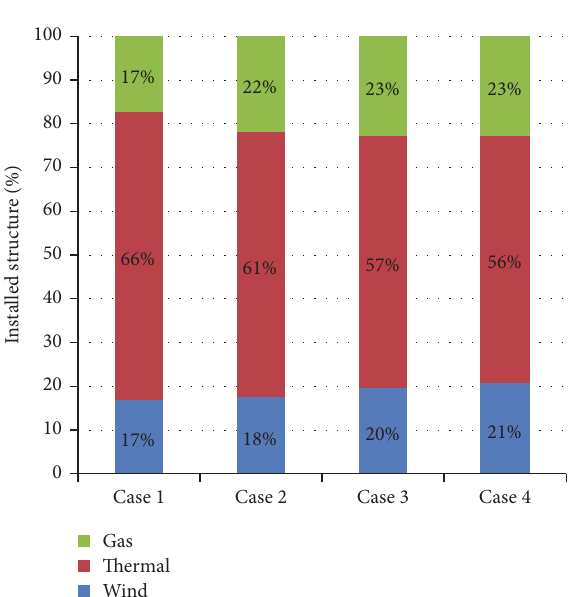
Figure 7: System installed structure at the end of period in 4